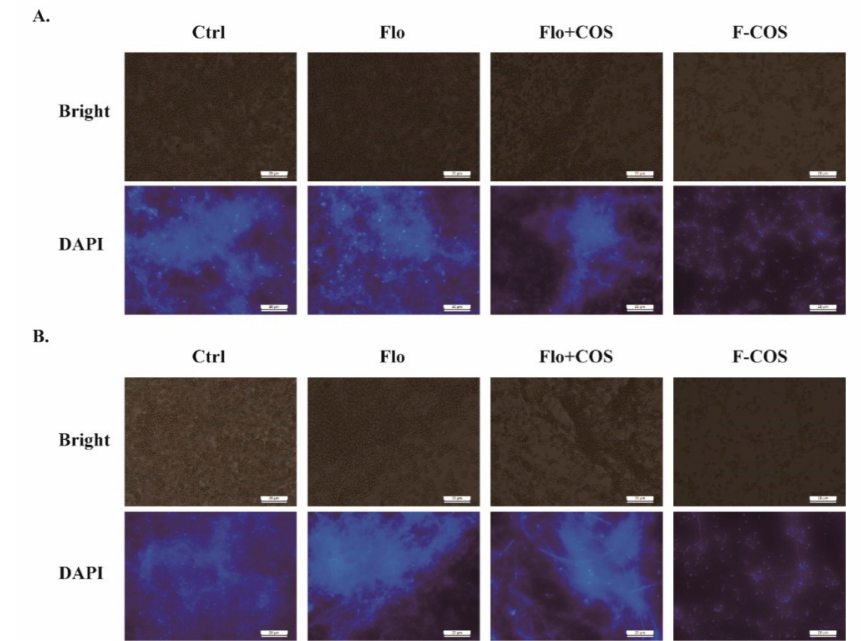
Figure 5. Micrographs of Streptococcus hyovaginalis biofilm cells treated with F-COS. Mature Biofilm ( A ) or planktonic cells cultured in biofilm formation condition ( B ) exposure to 0.25 mg / mL F-COS, florfenicol (Flo), a 1:1 mixture of florfenicol and COS (Flo + COS) were stained with 1 µ g / mL DAPI and observed under confocal microscopy. Scale bars, 20 µ m.